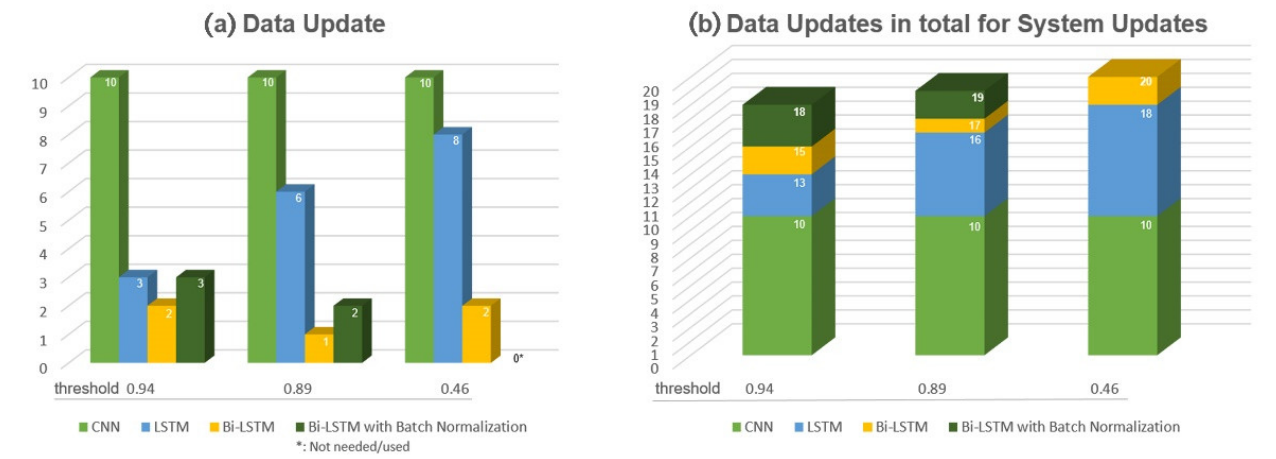
Figure 10. ( a ) Data Update Number in developing the Real-time Learning System ( b ) Data Updates in total for System Updates. *: Not needed/used.